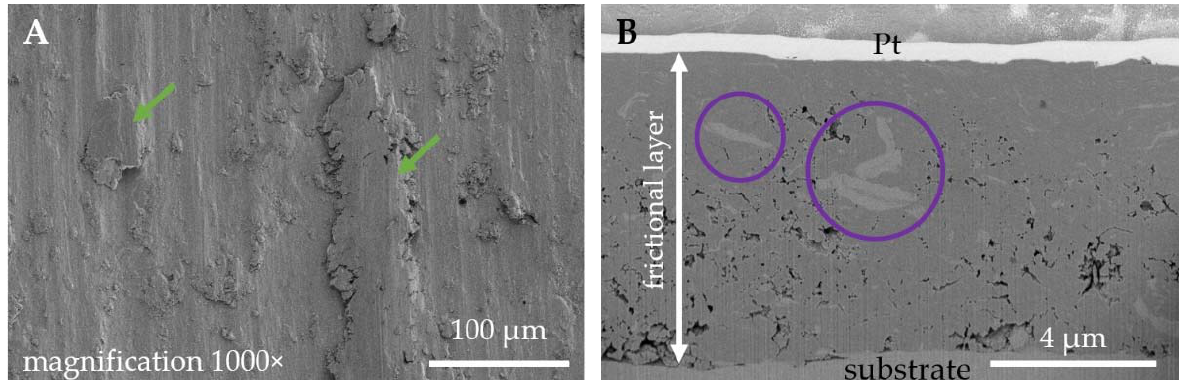
Figure 10. SEM micrographs of the wear tracks obtained for the TiN-coated 316L austenitic stainless steel (S2): ( A ) surface state of the wear track, ( B ) FIB-SEM cross-section of a wear track.